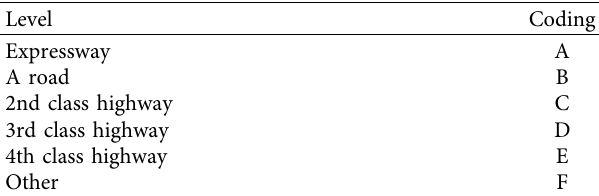
Table 6: The rule of naming and numbering of highway. Level